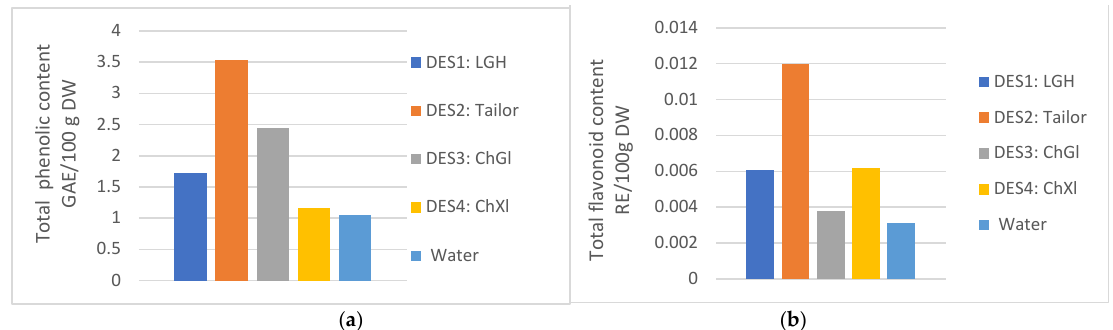
The values are expressed as the mean ± SD performed in triplicates.